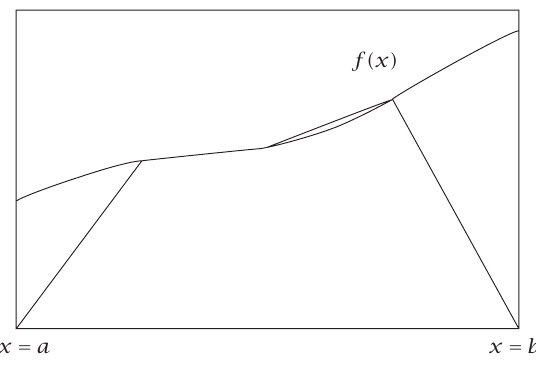
Figure 2.2 . Second approximation to the area under f(x)